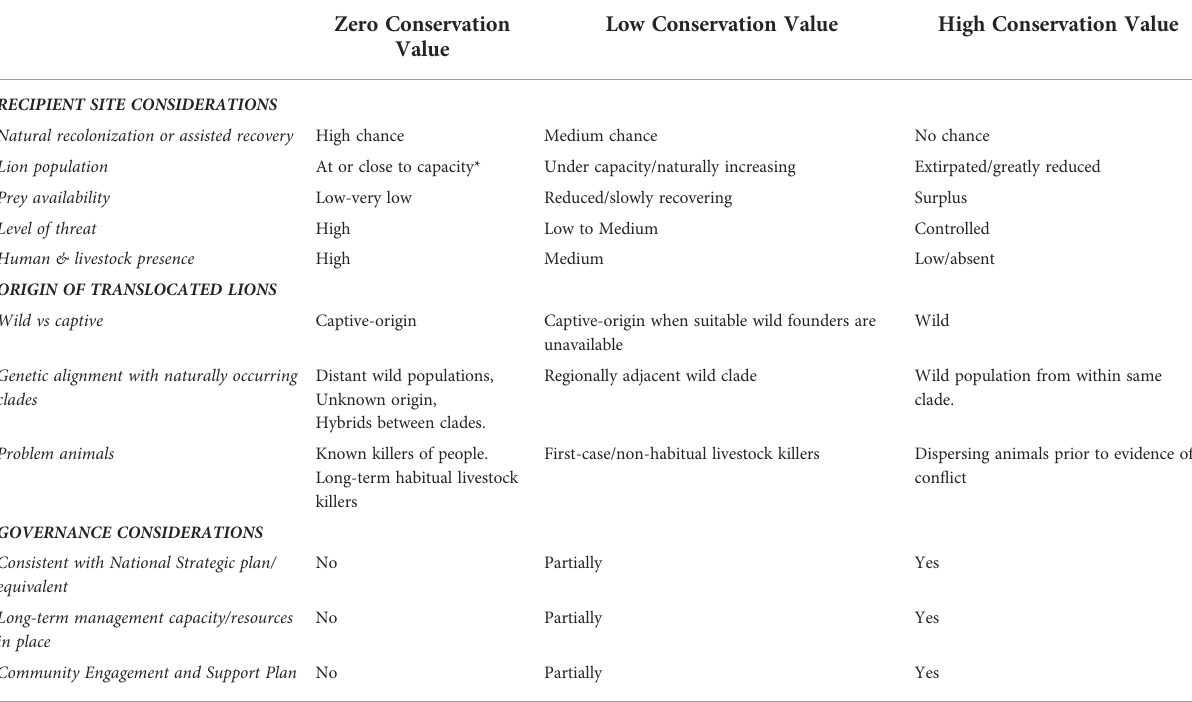
TABLE 2 Factors to consider for assessing the conservation value of